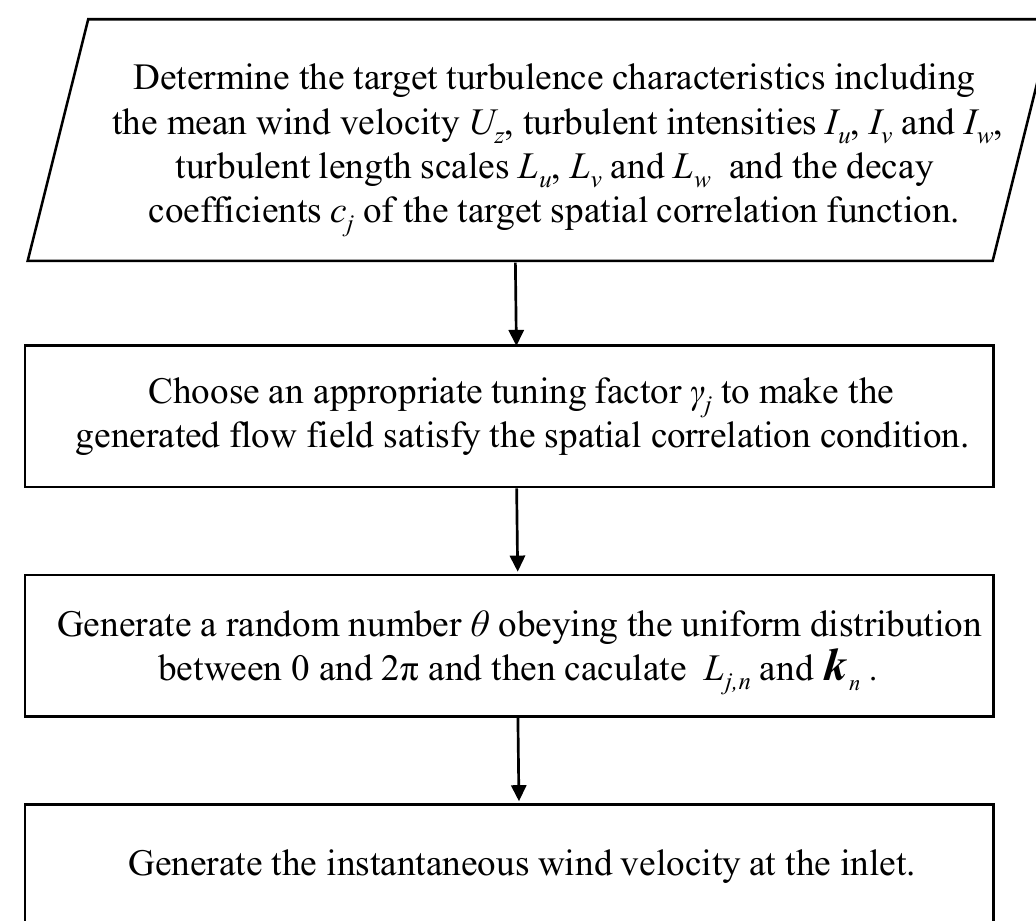
Figure 5. Flowchart of the NSRFG method.